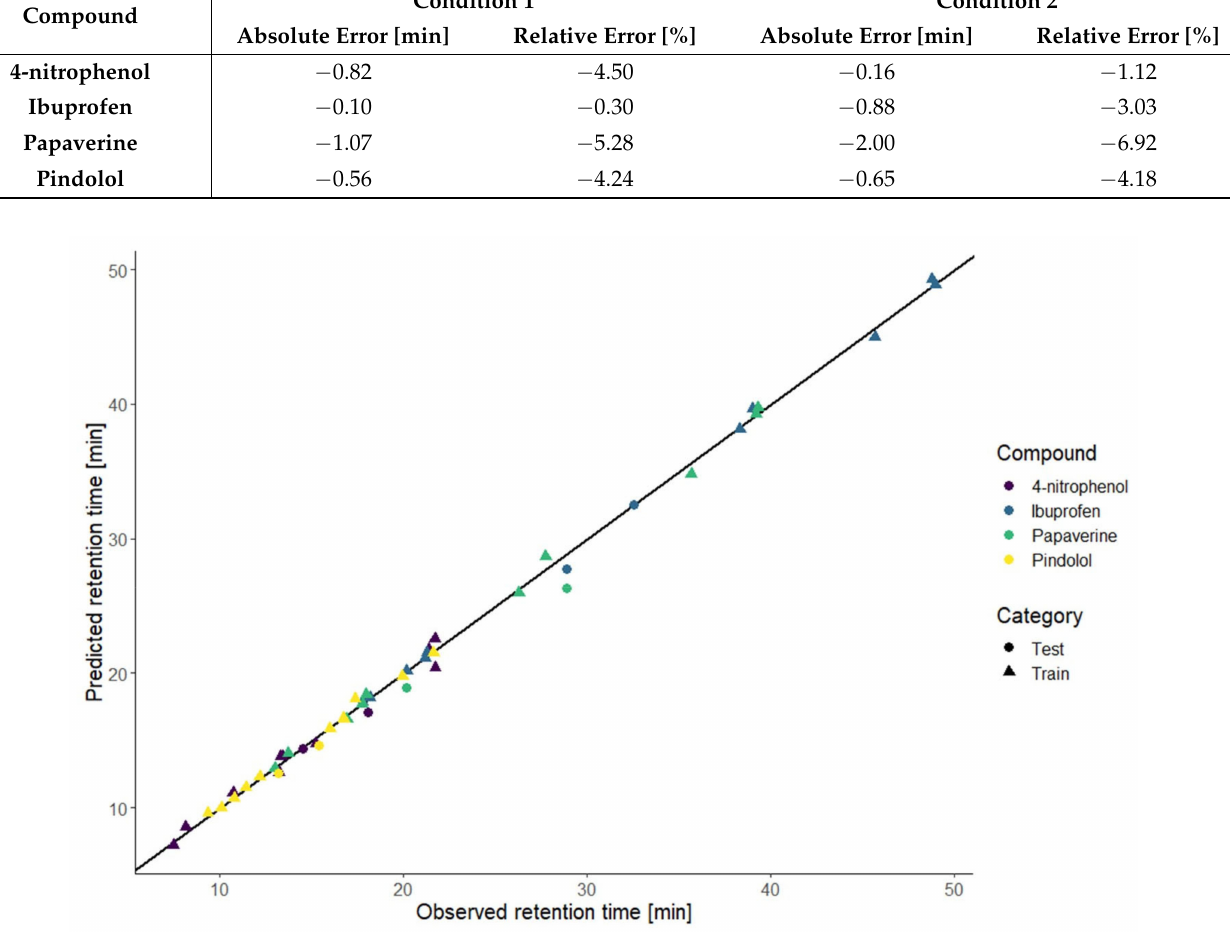
Figure 3. Predicted retention times versus observed retention times of the first test set for the training and the test